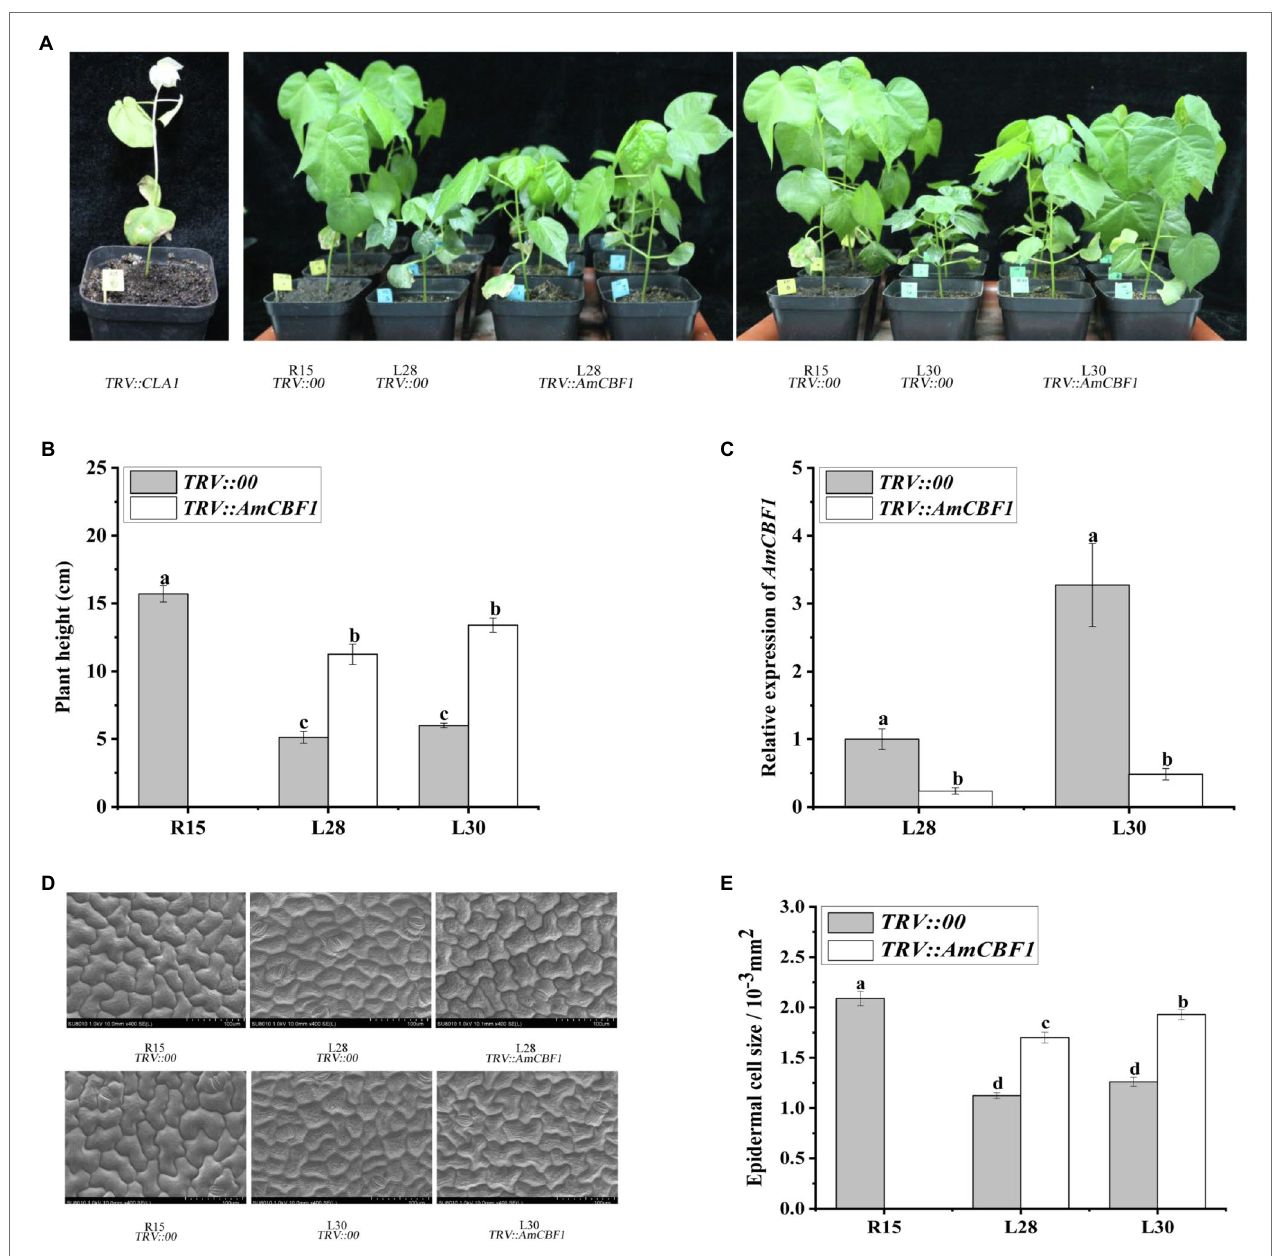
FIGURE 1 | Cotton phenotypes and leaf epithelial cells observed before and after silencing of AmCBF1 by VIGS. (A) Phenotype of cotton after AmCBF1 silencing. TRV:: CLA1 , albino phenotype, positive control; TRV:: AmCBF1 , AmCBF1 silencing in L28 and L30. (B) Cotton plant height after AmCBF1 silencing. (C) Relative expression of AmCBF1 in cotton leaves after AmCBF1 silencing. (D,E) Scanning electron micrographs and size of the upper epidermal cells of true leaves. Error bars indicate the standard error ( n = 3 biological replicates). Different lower-case letters above bars indicate a significant difference at p < 0.05 as determined using Duncan’s multiple range